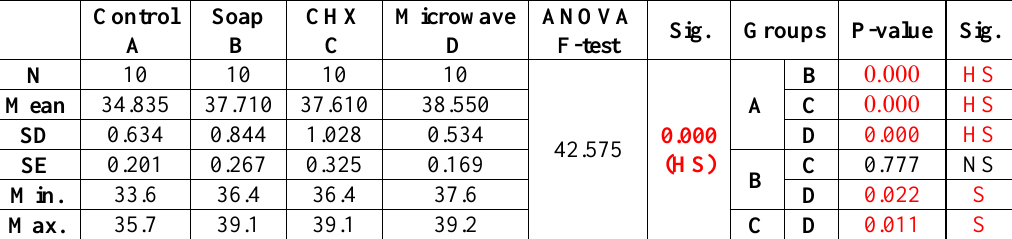
Table 2: Descriptive statistics, One-way ANOVA and LSD of Surface Hardness